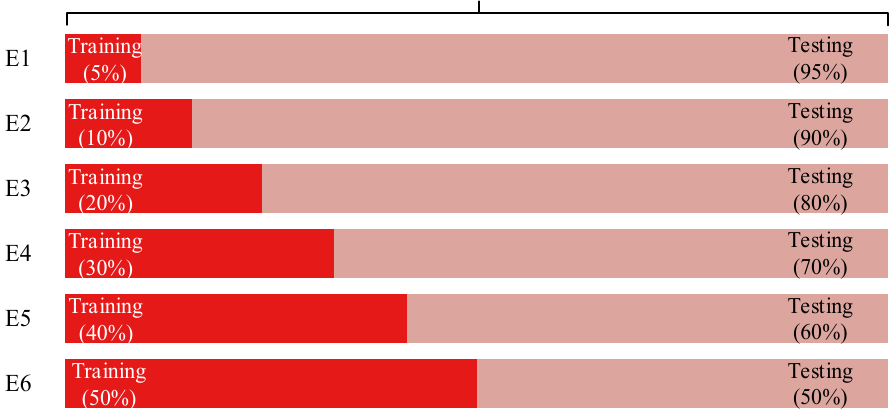
Table 1 . Comparison of classification accuracy on simulated database (using “WMsorting”). 1D, one- dimensional.